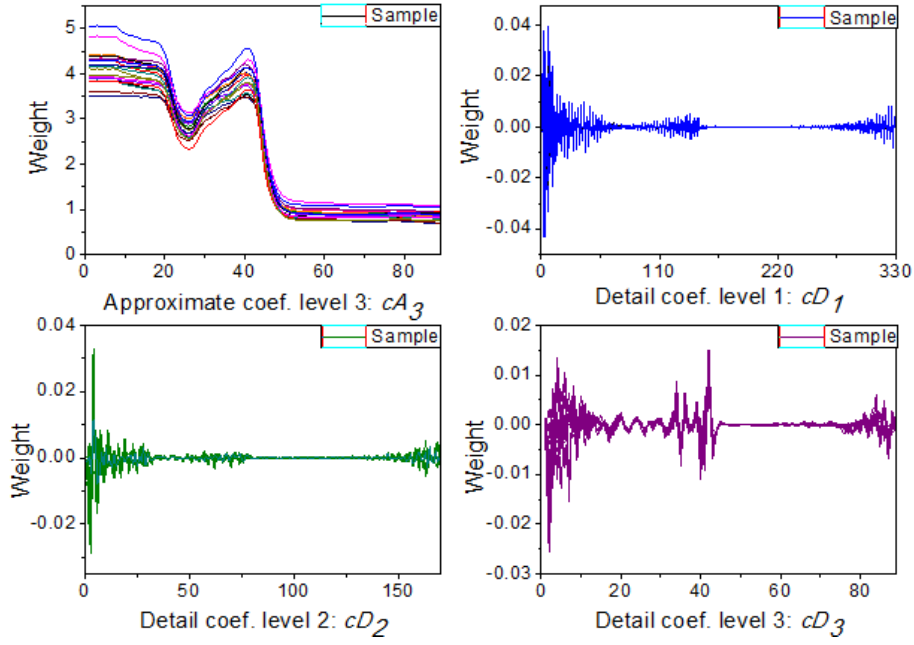
Figure 3. Wavelet decomposition coefficients by db5 at level 3.